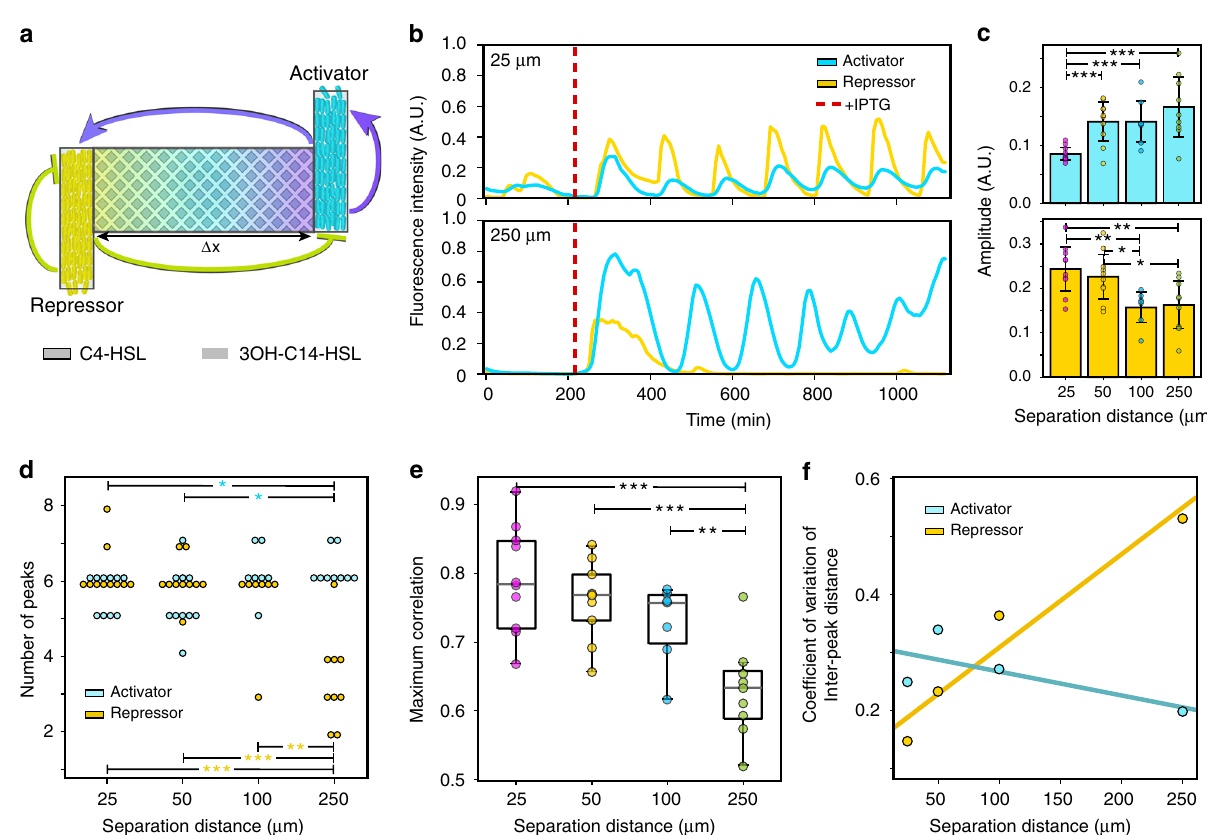
Fig. 4 Feedback loops dictate the role of distance on a distributed gene circuit oscillator. a Network schematic of activator and repressor strains in the MISTiC device. The activator and repressor exhibit bidirectional communication and dual-feedback loops mediated by the signaling molecules C4-HSL and 3OH-C14-HSL. The activator and repressor exhibit positive and negative feedback loops, respectively. b Representative normalized CFP and YFP fl uorescence intensities as a function of time in the 25 μ m (top) and 250 μ m (bottom) conditions. The red line indicates the time of induction with 1 mM IPTG. c Amplitude of peaks in the mean-subtracted CFP (top) and YFP (bottom) fl uorescence intensities across distances. Error bars represent 1 SD from the mean. Horizontal lines with stars denote a statistically signi fi cant difference ( P < 0.05) based on a two-sided t -test. * P < 0.05, ** P < 0.01, *** P < 0.001 (Supplementary Fig. 16). d The number of peaks as a function of distance for activator and repressor strains. Horizontal lines denote a statistically signi fi cant difference ( P < 0.05) based on a two-sided t -test. * P < 0.05, ** P < 0.01, and *** P < 0.001 (Supplementary Fig. 16). e Maximum cross-correlation between paired CFP and YFP time-series measurements for each distance. The horizontal lines within boxes denote the median and upper and lower edges represent the upper and lower quartiles, respectively. Upper and lower whiskers represent the 95th and 5th con fi dence intervals, respectively. Horizontal lines with stars denote a statistically signi fi cant difference ( P < 0.05) based on a two-sided t -test. * P < 0.05, ** P < 0.01, and *** P < 0.001 (Supplementary Fig. 16). f The coef fi cient of variation of the inter-peak distances (phase drift) as a function of separation distance for activator and repressor strains. Lines represent linear regression fi ts to the data. Source data are provided as a Source Data fi